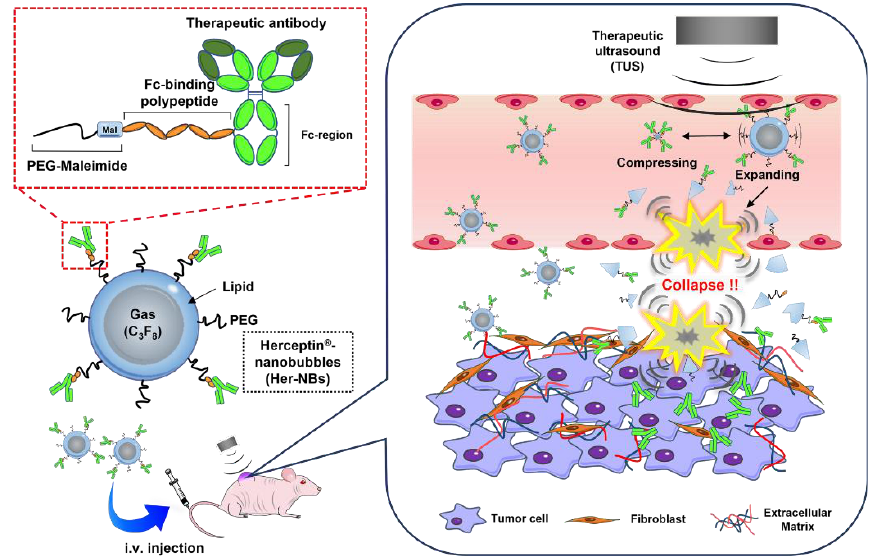
Figure 1. Schematic drawing of the structure of therapeutic antibody-modified nanobubbles (NBs) and the in vivo mechanism of action for the combination of therapeutic antibody-modified NBs and therapeutic ultrasound (TUS) exposure. Therapeutic antibody-modified NBs, which are loaded with Fc-binding polypeptide, expand to a much larger size upon TUS exposure and then collapse. The formation of jets caused by the collapse of NBs perforates surrounding blood vessels and membranes, enhancing the therapeutic antibody accumulation in tumor tissues.